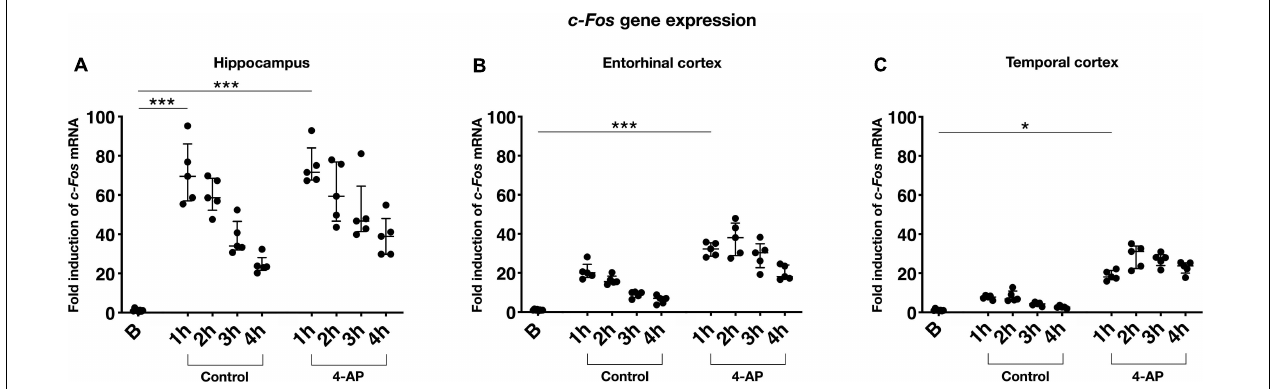
FIGURE 5 | Activity and time dependent c-Fos gene expression in rat slices. Induction of c-Fos mRNA relative to basal gene expression in (A) Hippocampus, (B) Entorhinal cortex, and (C) Temporal cortex, respectively. All investigated conditions are represented: control slices (control), 4-AP treated slices (4-AP) with experimental duration of 1, 2, 3 or 4 h. For relative quantification in RT-qPCR, Ywhaz was used as reference gene. Scatter plots show means of individual rats ( n = 20) since tissue was pooled before RT-qPCR, superimposed lines represent median ± interquartile range (* p < 0.05, *** p < 0.001).